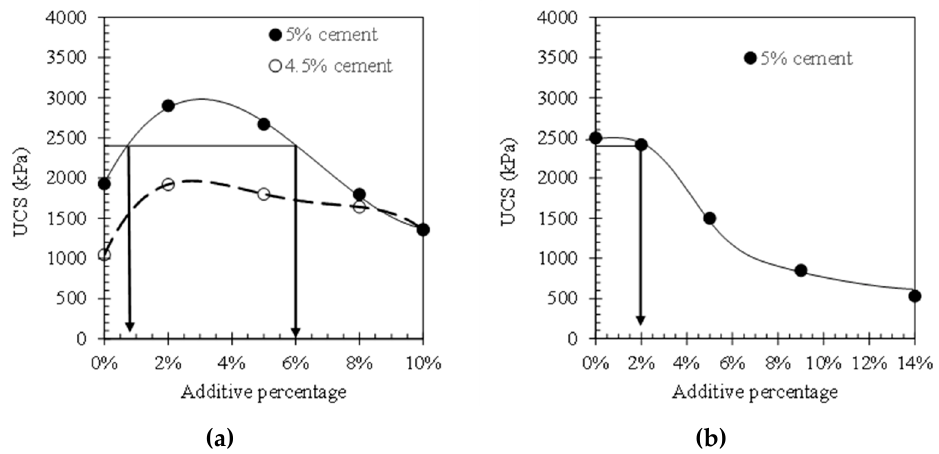
Figure 4. Determination of additive percentage in the mixture. ( a ) Granitic soil, and ( b ) lateritic